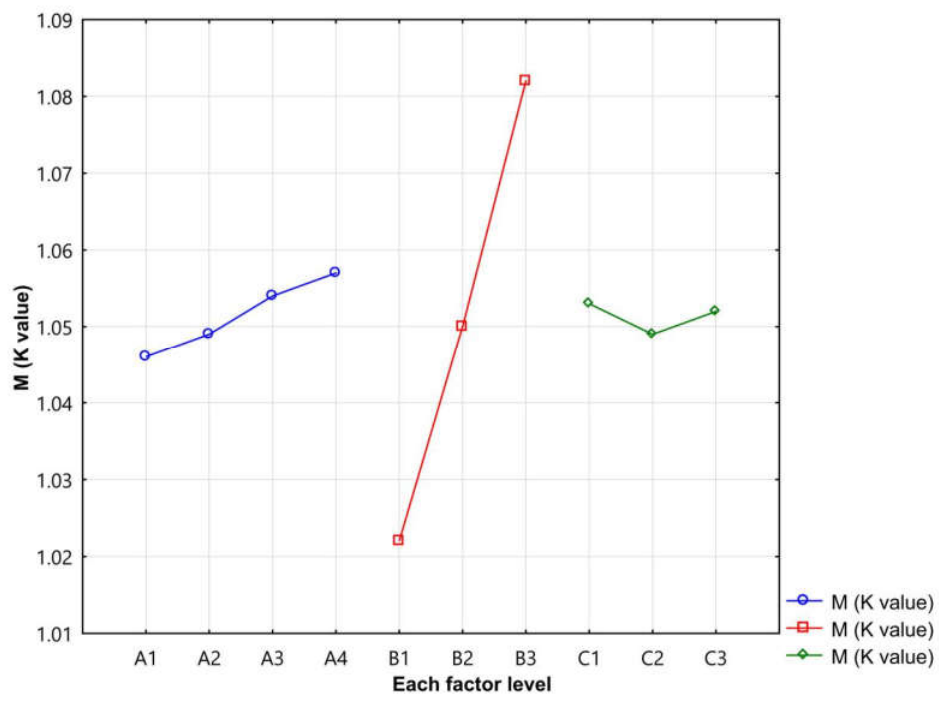
Figure 4. Relationship between skin microcirculation blood flow promotion multiples and fabric structural parameters. structural According to the results in Figure 4, in factor B, the order of blood flow promotion multiples sorted was as follows: B3 > B2 > B1, i.e., when the magnetic powder content of